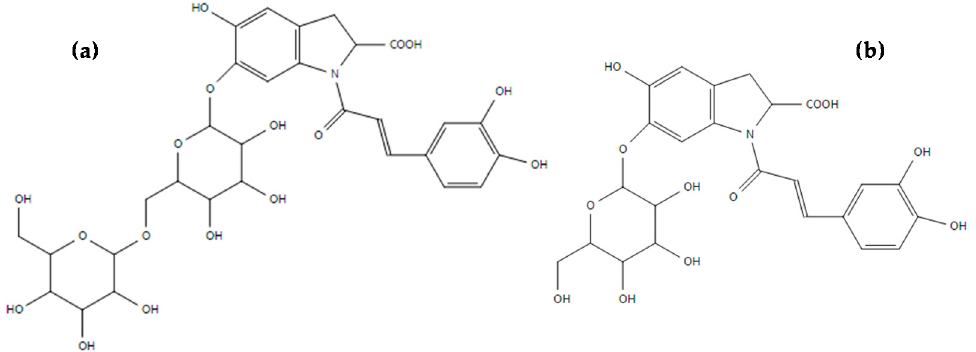
Figure 4. Proposed structures of oleracein X ( a ) and oleracein Y ( b ).